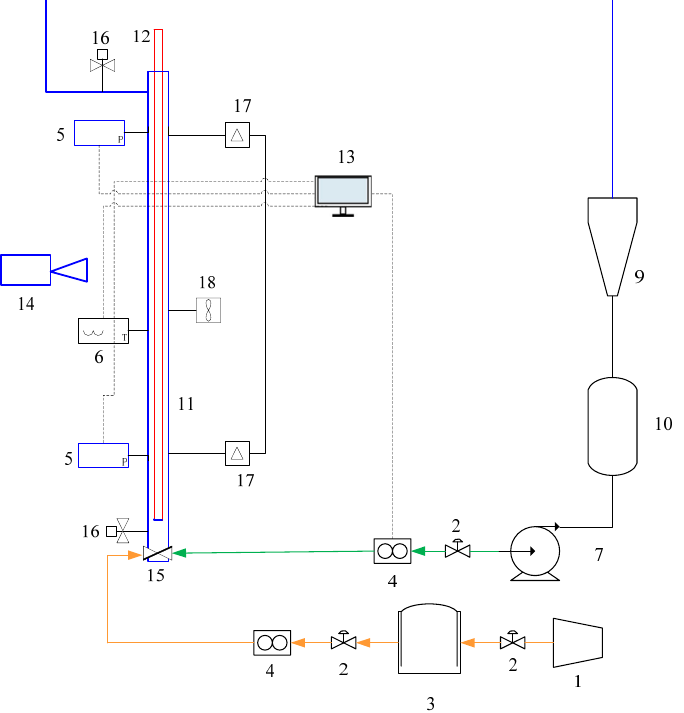
Figure 1. Flow chart of the experimental device for circulating air-liquid two-phase flow. 1—Air com-